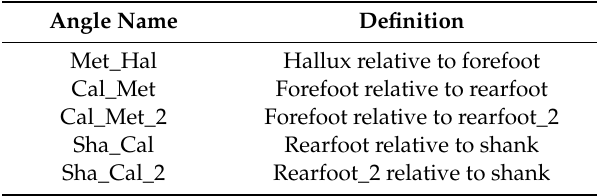
Table 3. The definition of the abbreviations for the angle names.